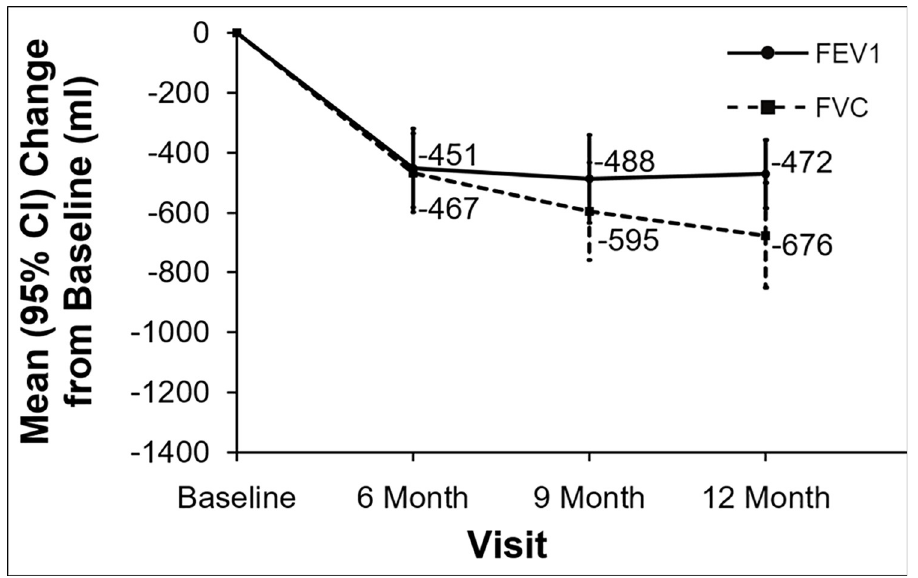
Fig 2. Pulmonary function during observation–values as observed. FEV 1 –forced expiratory volume in 1 second, FVC- forced vital capacity, ml–milliliters, CI–confidence interval.